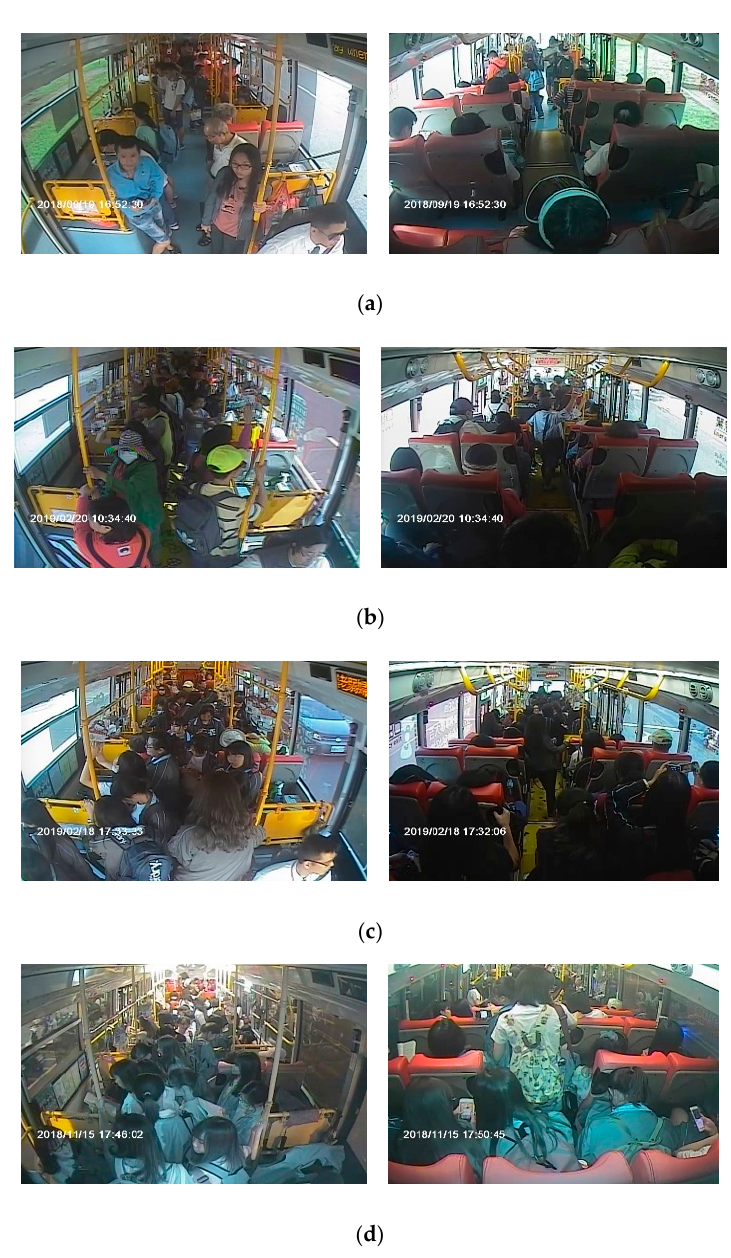
Figure 12. Examples of crowded scenes: ( a ) 25 passengers, ( b ) 30 passengers, ( c ) 35 passengers, and ( d ) 40 passengers. Table 2. Performances of different methods for the crowded bus dataset.